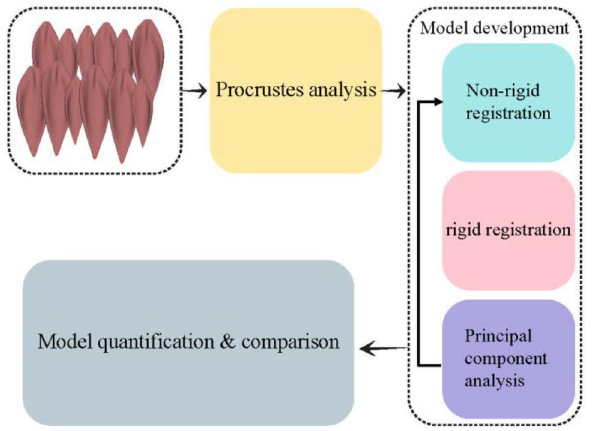
Figure 1. The flowchart of the model generation and quantification